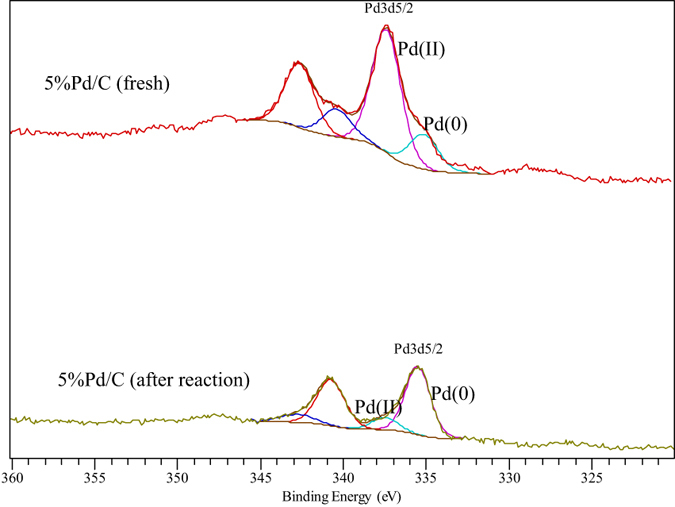
XPS spectra of 5% Pd/C catalyst before and after the room temperature continuous flow Ullmann reaction.Reaction conditions (for the 5% Pd/C after reaction: 0.1 M PhI and 0.25 M K2CO3 in MeOH:H2O 3:1, 0.3 mL.min−1, 2 h on stream).